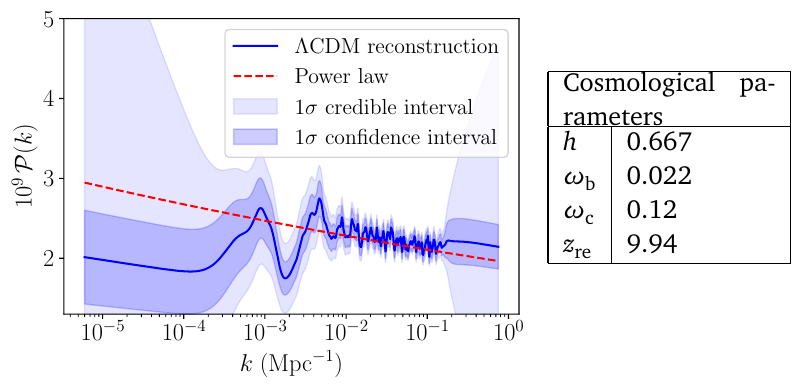
Figure 5: Reconstruction (blue line) of the PPS from Planck Public Release 2 T T , T E and EE data assuming a Λ CDM cosmological model with cosmological parameters listed in the table (right). The purple band indicates the 1 σ confidence interval and the light blue band indicates the 1 σ credible interval. A power-law PPS (red dashed = 0.968 is line) with n s